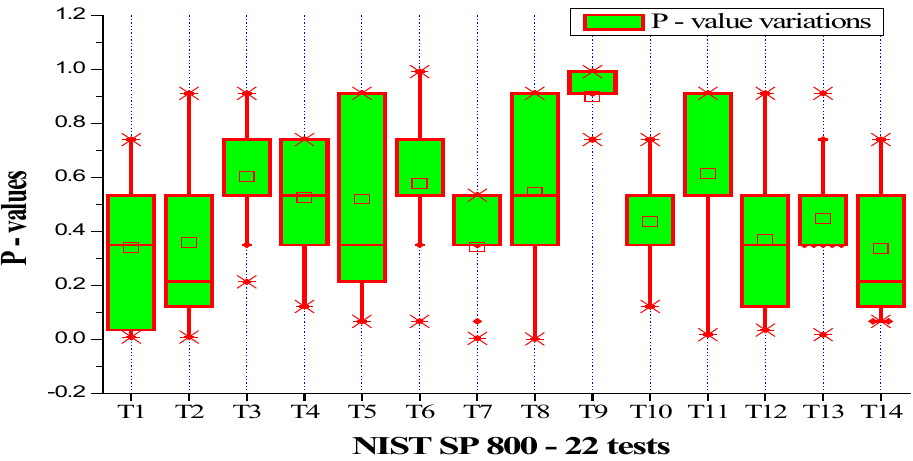
Figure 6. Box chart plot of the p values of the raw true random bits.